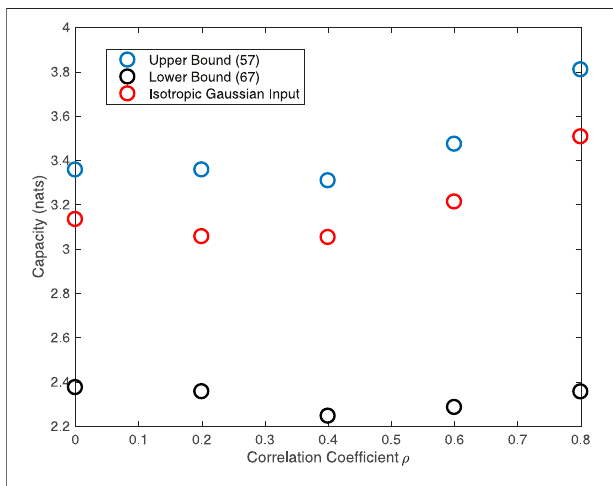
FIGURE 4 | Capacity bounds for two-dimensional sub-Gaussian α -stable noise channels for varying noise dependence ρ subject to a power constraint p (cid:3) 0.01, with Σ given in Eq. 73 and α (cid:3)